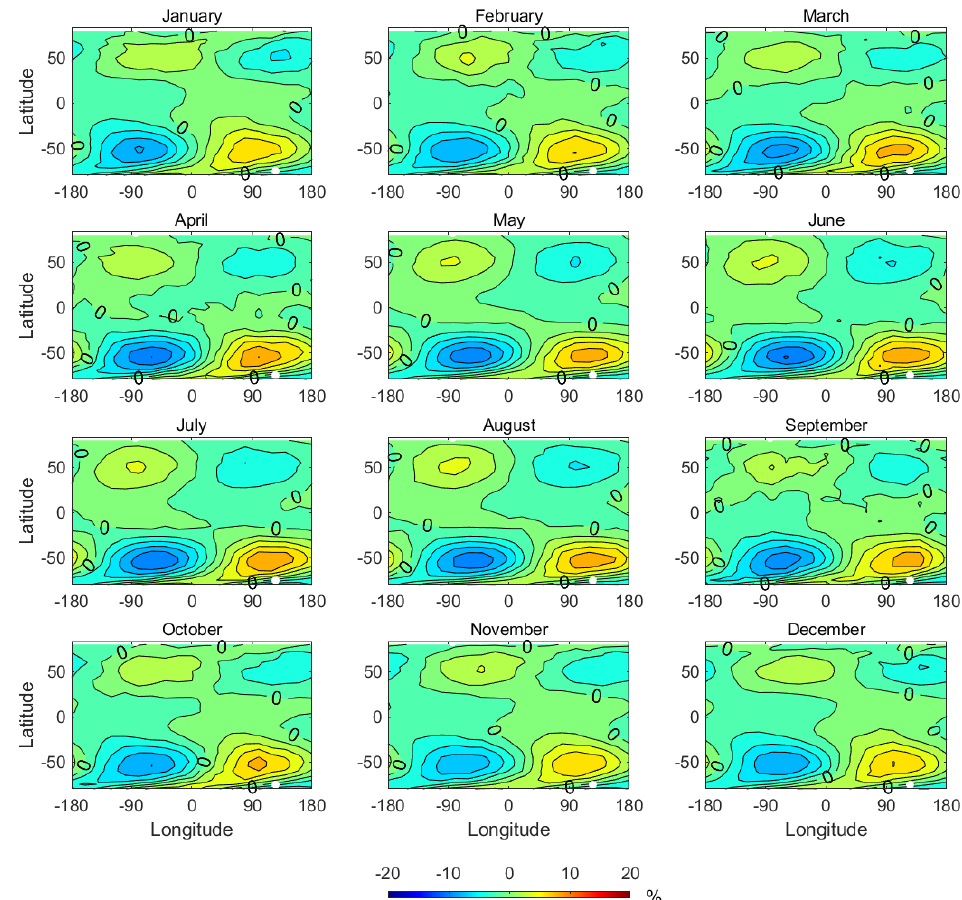
Figure 11. Same as Figure 7, except for the atmospheric number density.